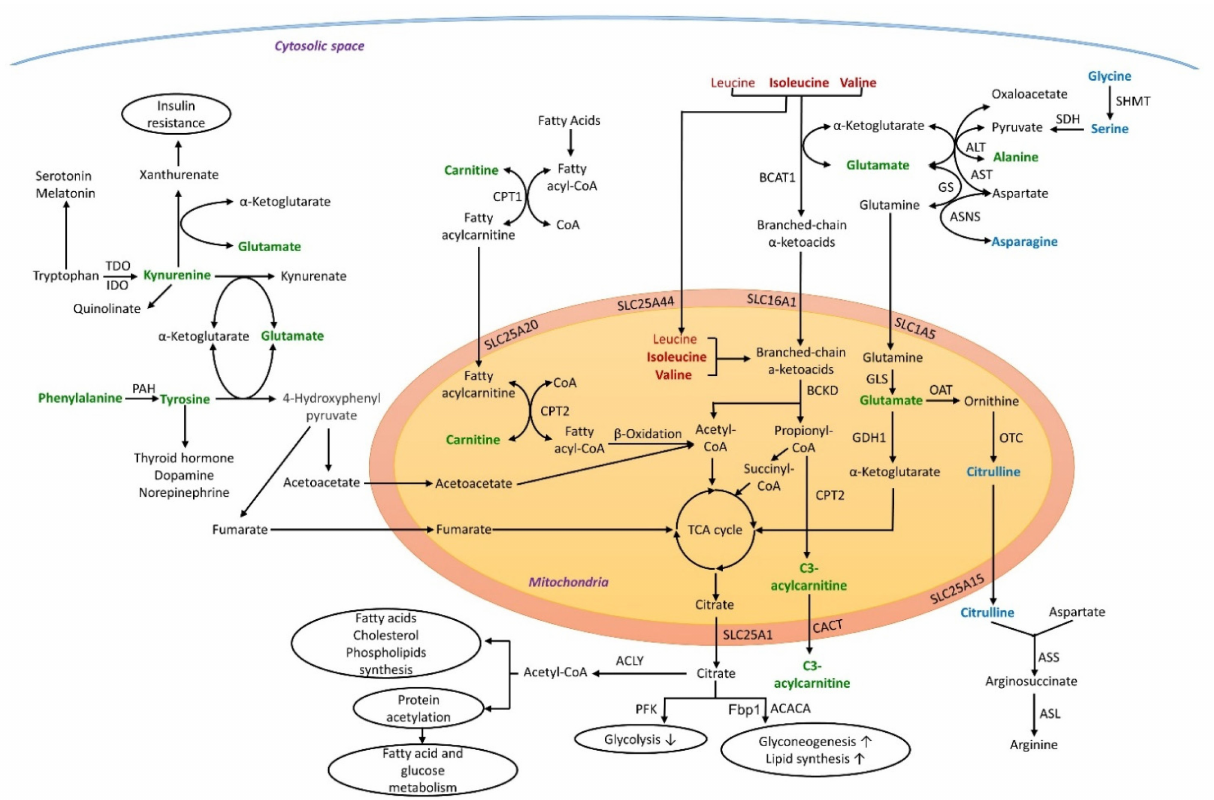
Figure 3. Metabolic pathways associated with BMI and obesity. Bold font indicates metabolites significantly associated with obesity. Red indicates branched-chain amino acids; blue indicates metabolites negatively associated with obesity; green indicates metabolites positively associated with obesity. ACACA: acetyl-CoA carboxylase alpha; ACLY: ATP-citrate lyase; ALT: alanine